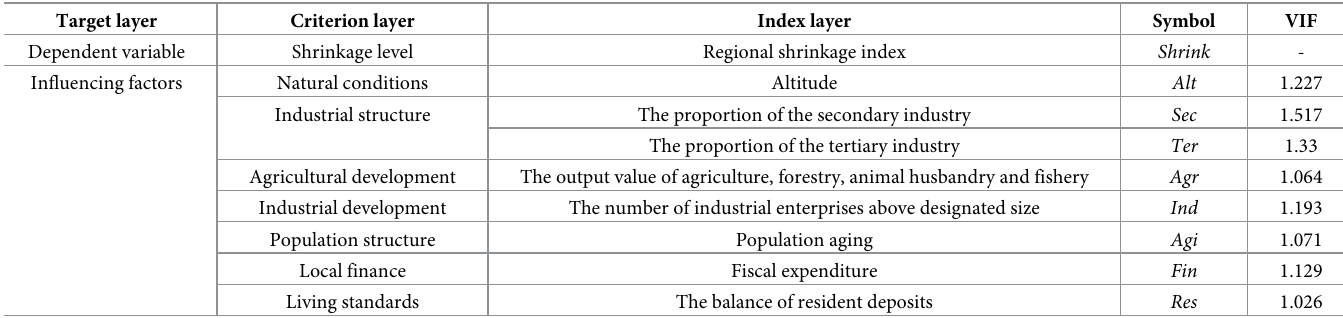
Table 5. Influencing factor system of regional shrinkage of the three northeastern